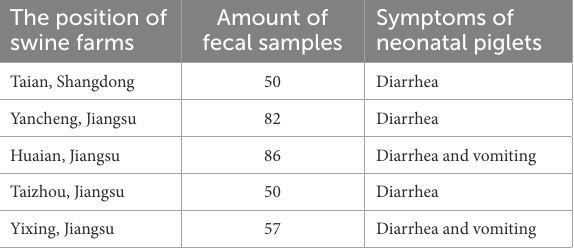
TABLE 1 The information on clinical field samples from swine farms. The position of swine